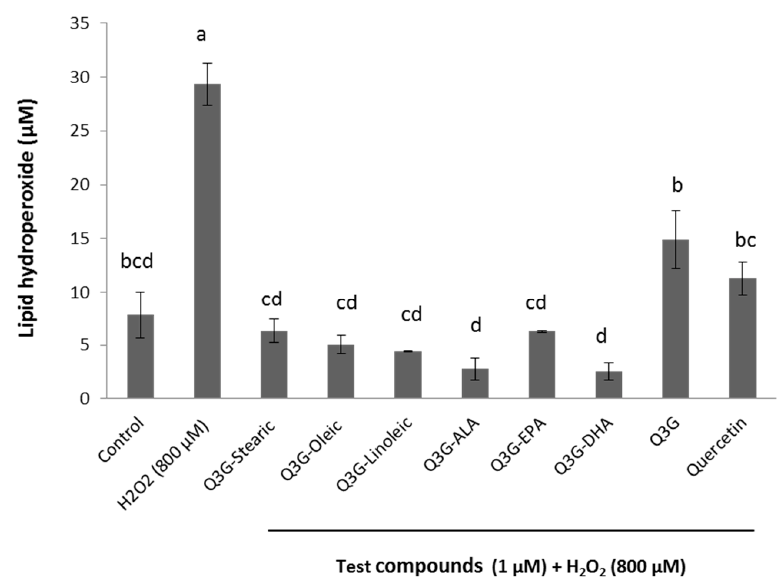
Figure 7. Production of lipid hydroperoxides under H 2 O 2 -induced oxidative injury in WI-38 cells. Cells were pre-incubated with test compounds for 48 h followed by 800 µM H 2 O 2 for 3 h and production of lipid hydroperoxides was determined. Control contains the cells with no incubation of test compounds and no oxidative injury. Data were expressed as mean ± SEM ( n = 3), means sharing same letters are not significantly different ( p ≤ 0.05).